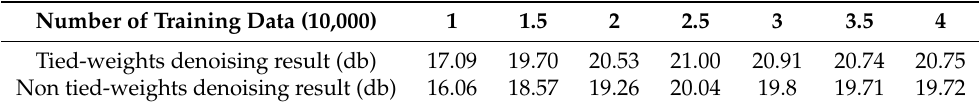
Table 3. Denoising results with respect to the training number of tied weights and non-tied weights.